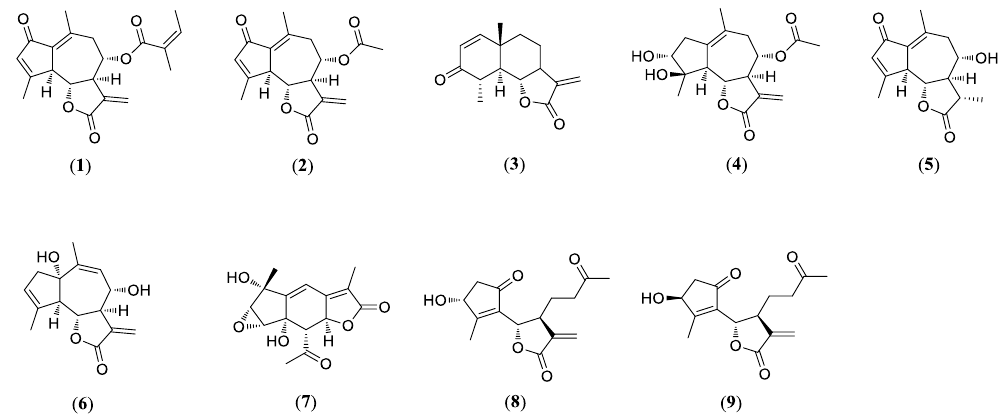
Figure 1. Chemical structures of nine sesquiterpenes including moxartenolide (compound 1 ), dehydromatricarin A (compound 2 ), tuberiferin (compound 3 ), argyinolide G (compound 4 ), deacetylmatricarin (compound 5 ), rupicolin A (compound 6 ), acrifolide (compound 7 ), 3- epi- iso -seco -tanapartholide (compound 8 ), and iso -seco -tanapartholide (compound 9 ) isolated from Artemisia argyi .